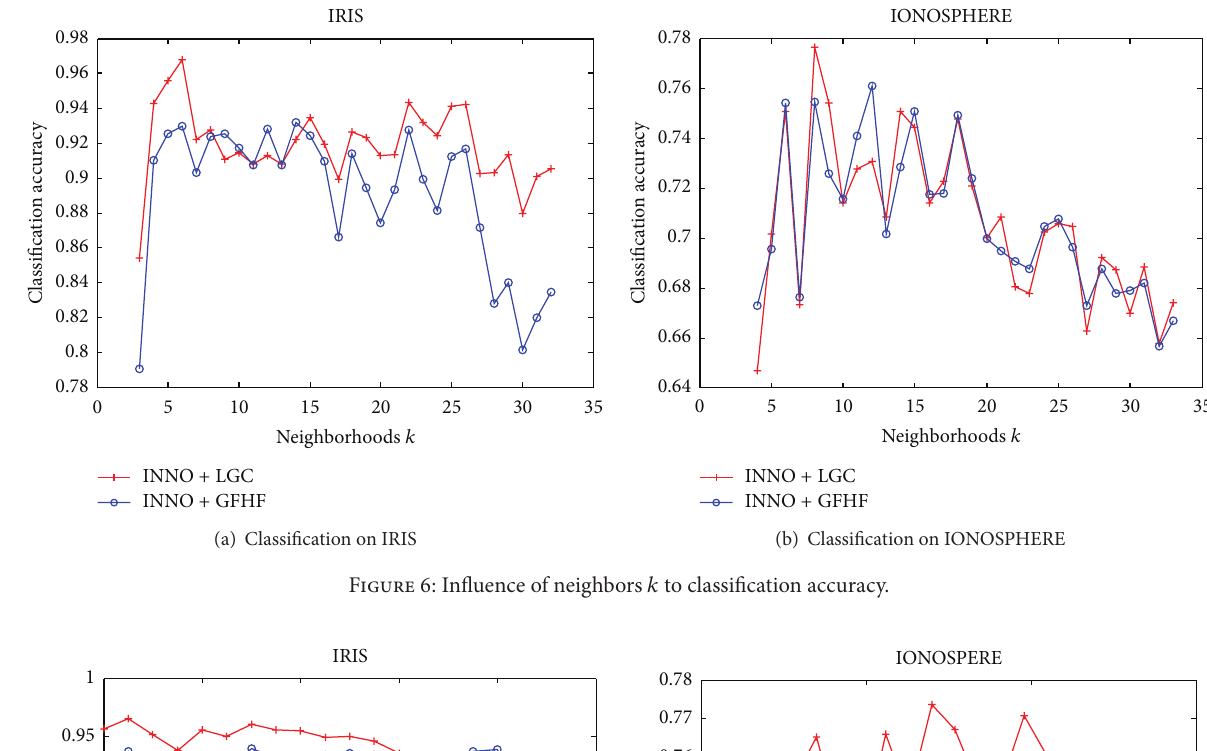
Figure 6: Influence of neighbors 𝑘 to classification accuracy.